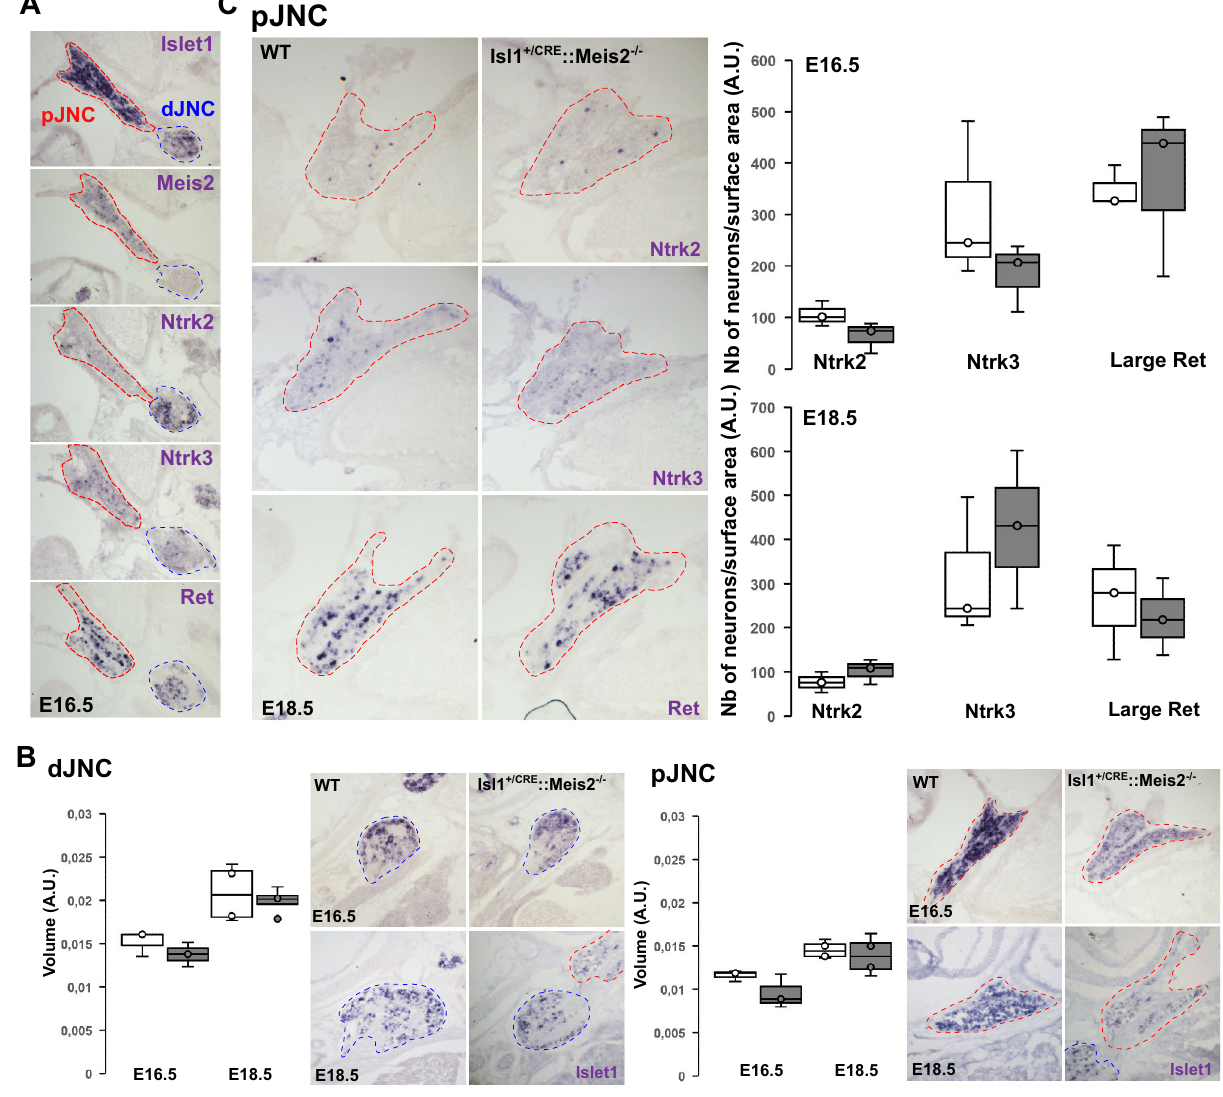
Figure 6. Neurons of the Jugular-Nodose complex are not lost following Meis2 inactivation. ( A ) Expression of Meis2 in the Jugular-Nodose complex of E16.5 mouse embryos. In situ hybridization (ISH) for Meis2 , Islet1 and other well-known markers for mechanosensitive neurons such as Ntrk2 , Ntrk3 and Ret on sagittal sections showed that Meis2 is expressed by neuronal subpopulations in the proximal Jugular-Nodose complex (pJNC) in a pattern comparable with mechano-sensitive DRG neurons as previously described, but not in the distal Jugular-Nodose complex (dJNC). Red dotted lines delineate the pJNC and blue dotted lines delineate the dJNC. ( B ) Size Measurements of the pJNC and dJNC following ISH for Islet1 showed no change in the size of the ganglia at E16.5 and E18.5 of Isl1 CRE ::Meis2 LoxP/LoxP embryos compared to WT embryos (n = 3 for each genotype). Images are representative of the different ISH staining in the pJNC and dJNC. ( C ) Graphs showing the counting of Ntrk2, Ntrk3 and large Ret-positive neurons in the pJNC at E16.5 and E18.5. No changes were evidenced in the number of these neurons in Isl1 +/CRE ::Meis2 LoxP/LoxP embryos compared to WT (n = 3 for each genotype). Images are representative of the different ISH staining in the